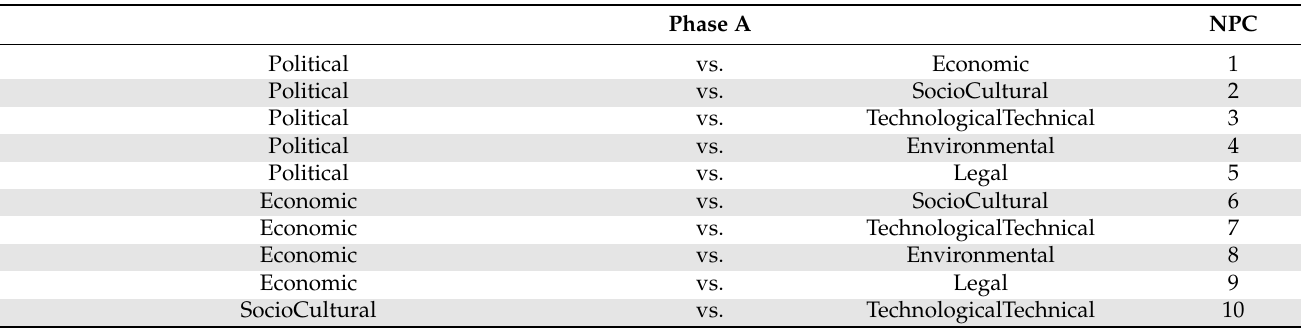
Table 2. Pairwise Comparisons